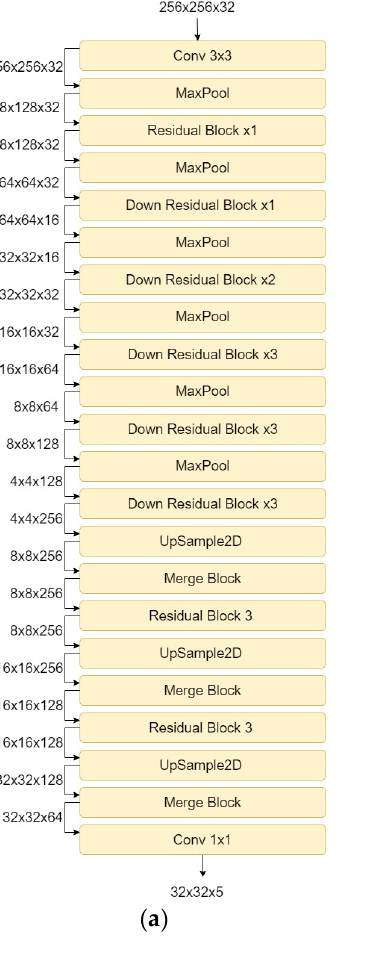
Figure 4. CNN structure for license plate number detection. The structure is identical, but the input and output differ: ( a ) structure of the first network for preliminary number detection; ( b ) structure of the second network for precise number